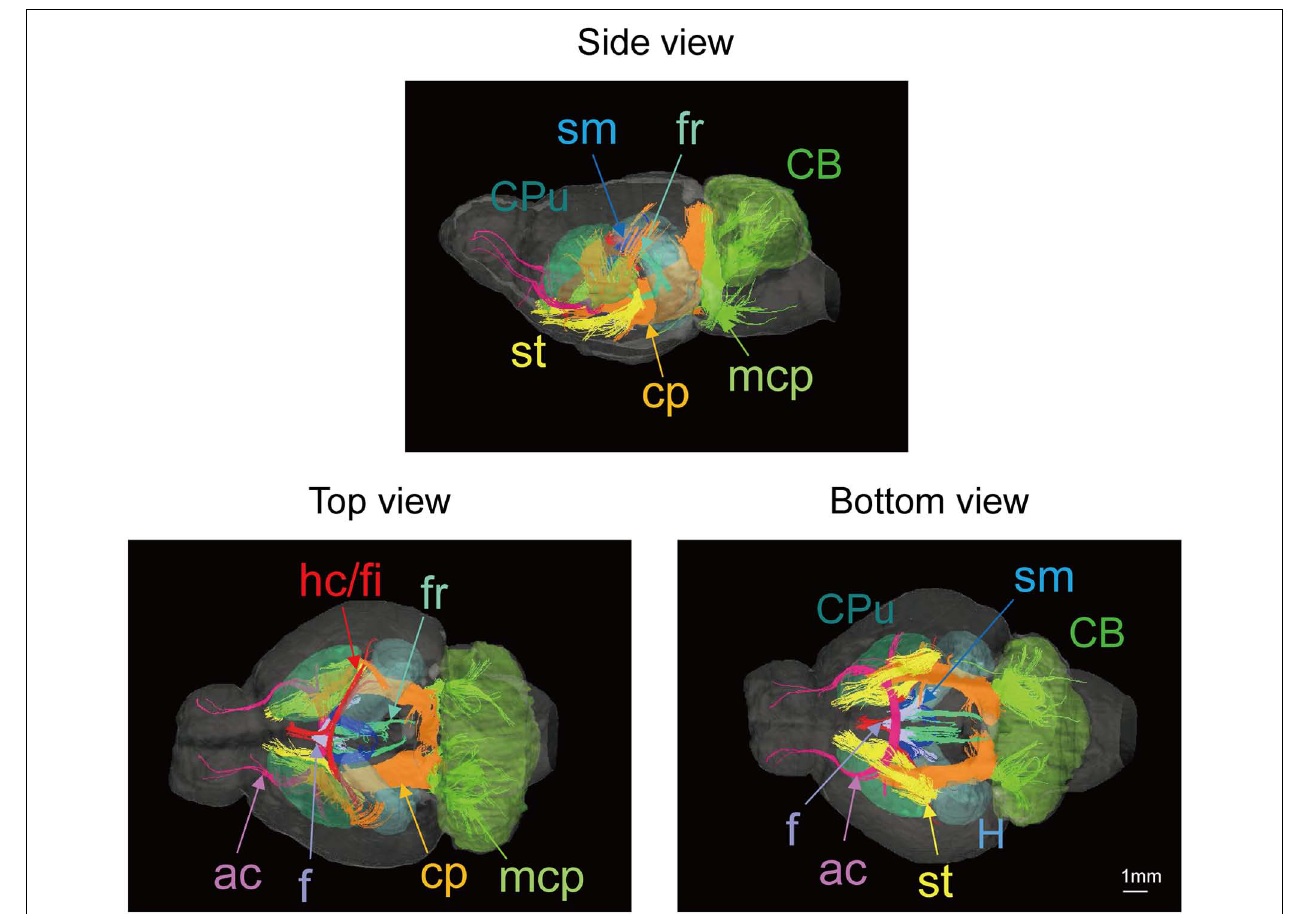
FIGURE 3 |Tractography showing the white matter tracts in 3D (upper, side view; lower left, top view; lower right, bottom view). ac, anterior commissure (pink); cp, cerebral peduncle (orange); f, fornix (light purple); fr, fasciculus retroflexus (light green); hc/fi, hippocampal commissure/fimbria